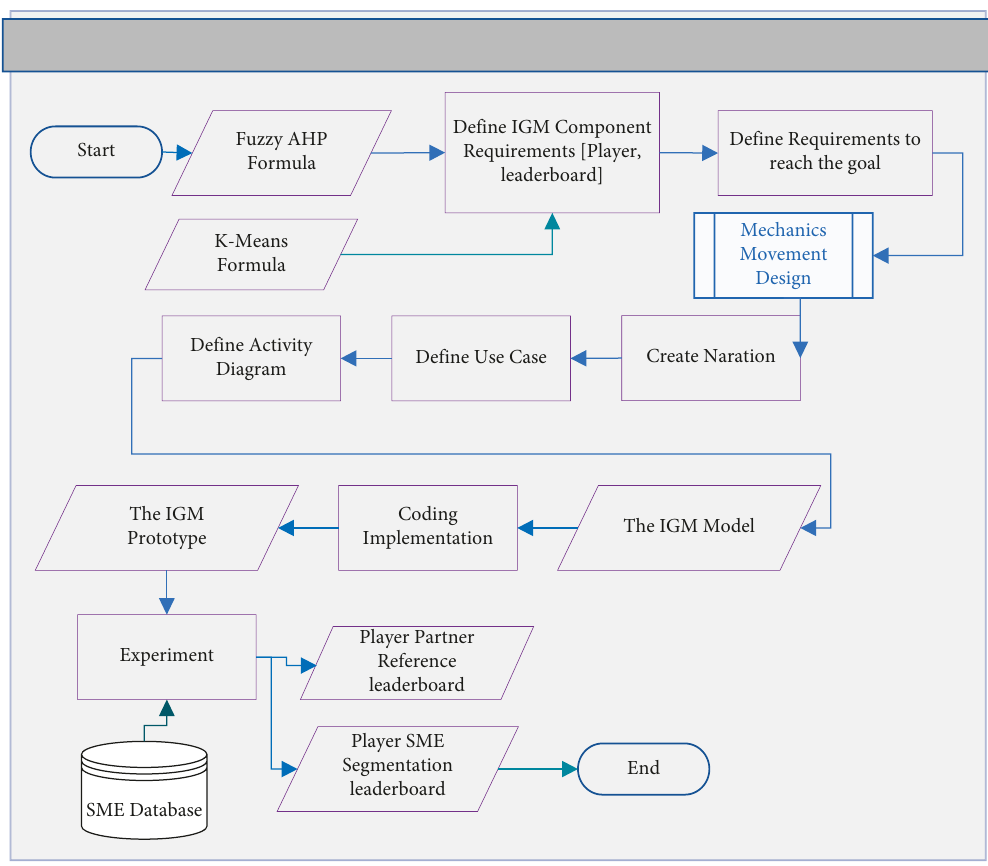
Figure 1: Research